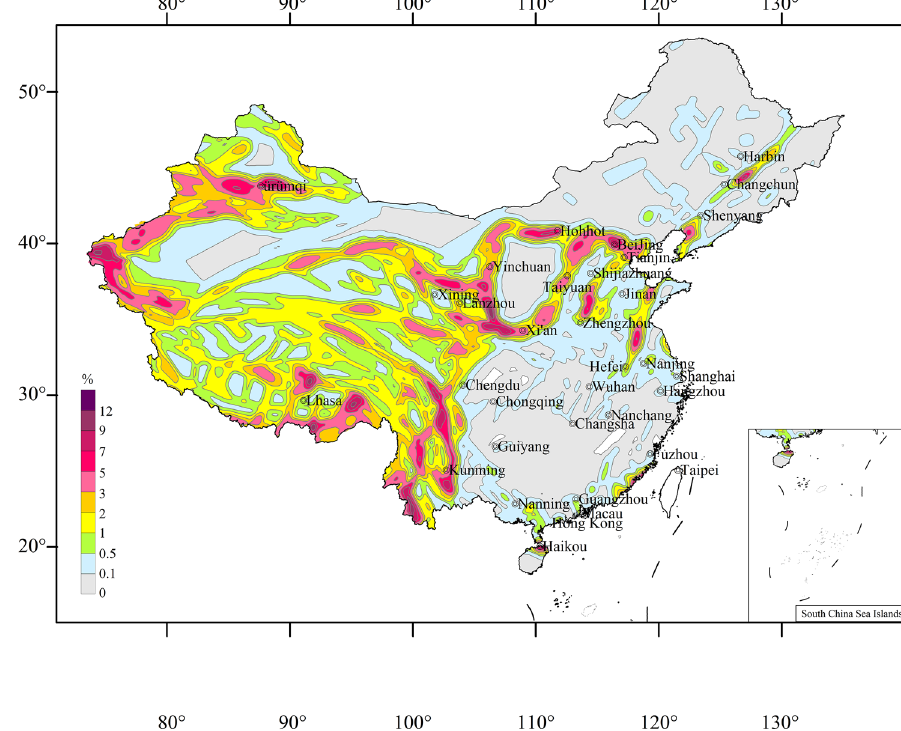
Fig. 12 Spatial distribution